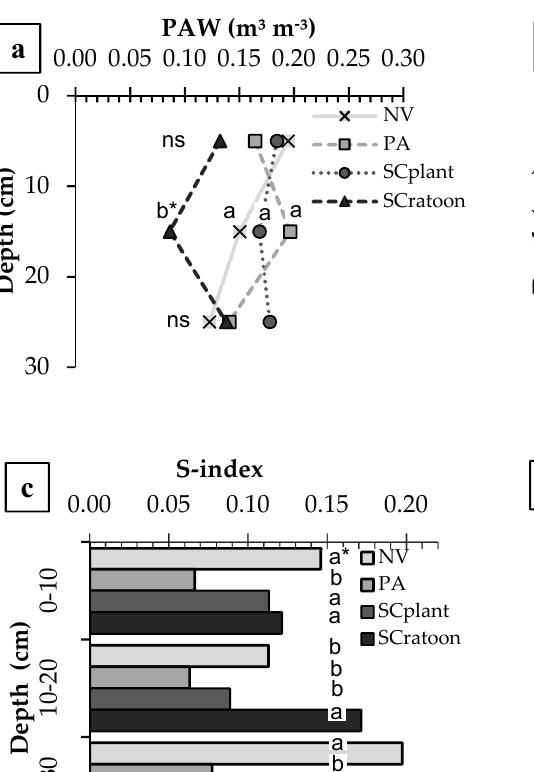
Figure 5. Plant-available water (PAW) content ( a , b ) and S-index ( c , d ) from 0–10, 10–20, and 20–30 cm layers under native vegetation (NV), pasture (PA), sugarcane plant (SCplant), and sugarcane ratoon (SCratoon) at Sandy soil ( a , c ) and Clayey soil ( b , d ). * Mean values within each site in the same depth followed by the same letter do not differ among themselves according to Tukey’s test ( p < 0.05). ns Not significant.